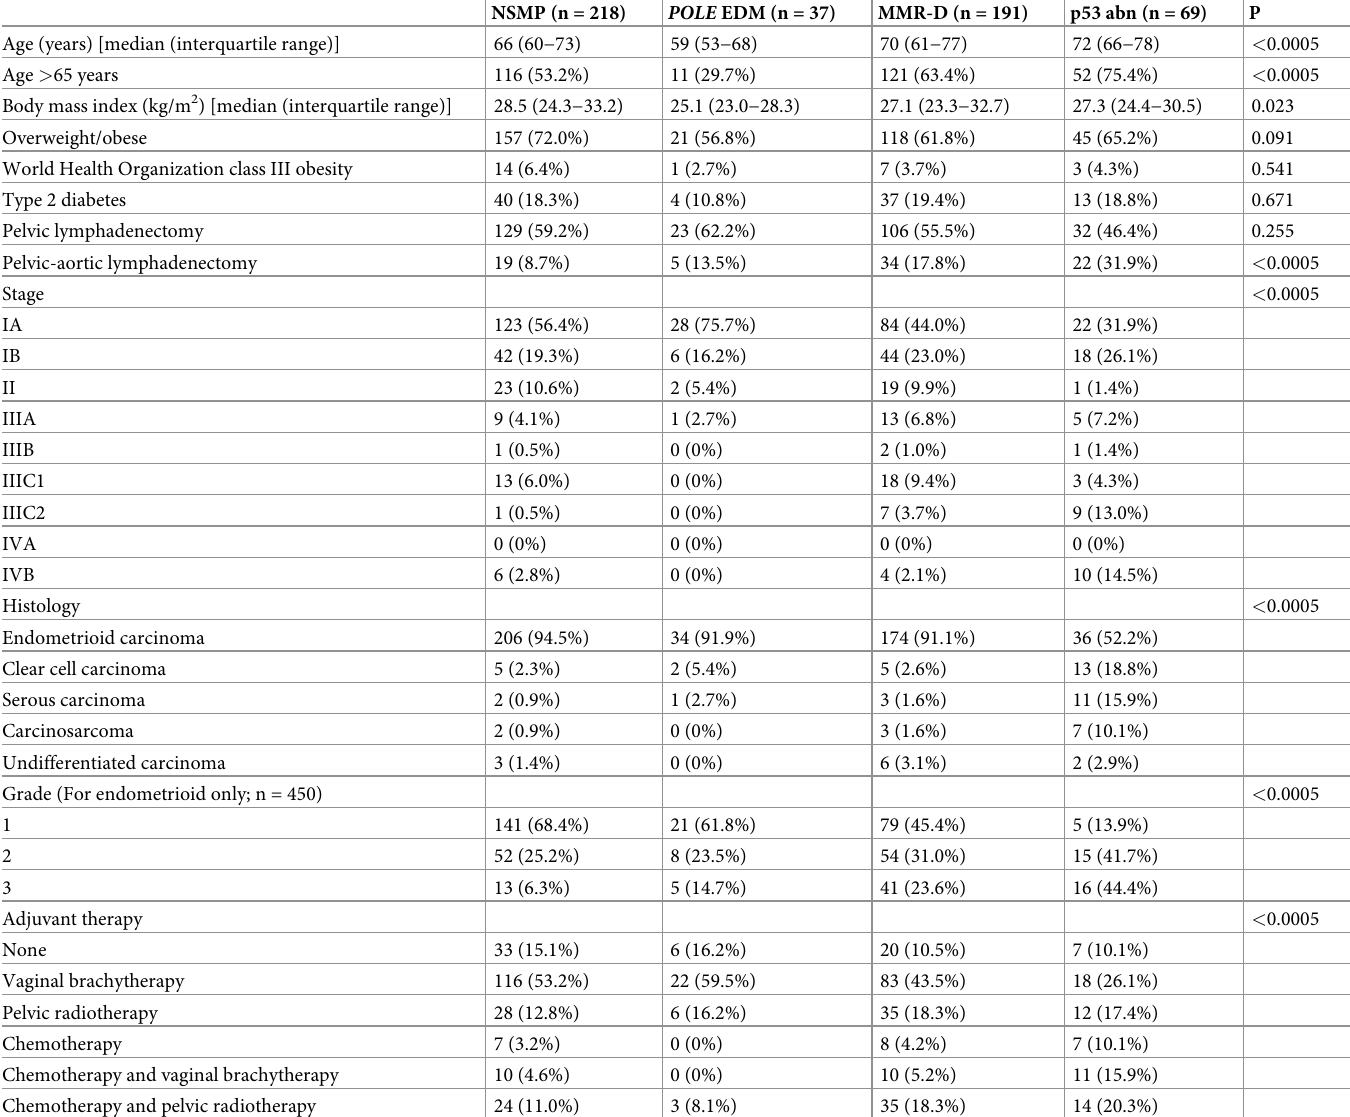
Table 1. Characteristics of the study population according to molecular